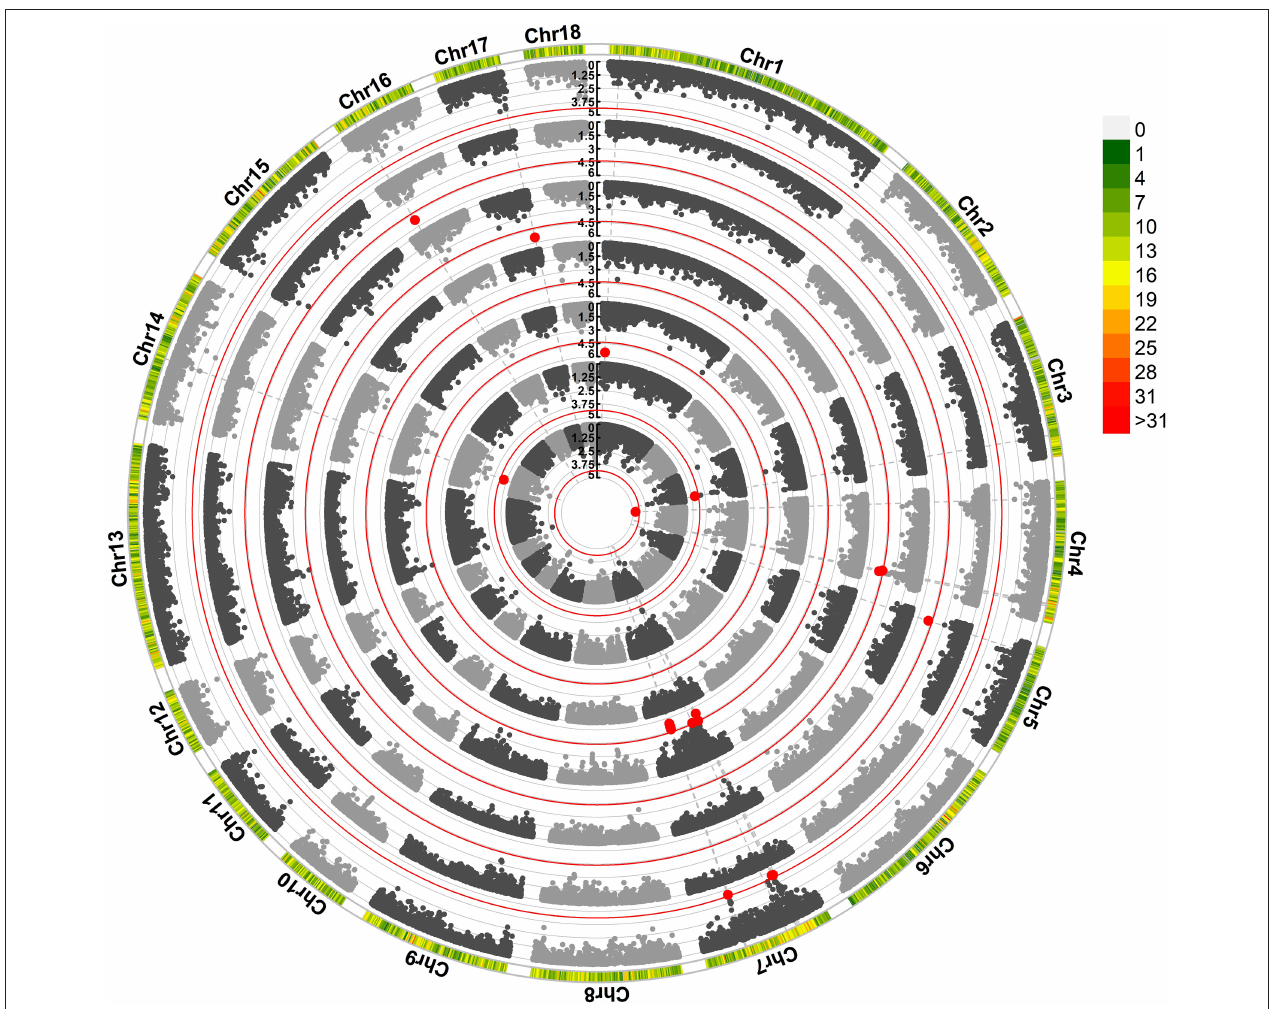
FIGURE 1 | Manhattan plots obtained in the GWAS of litter-size traits. The red line identifies the cut-off for suggestive significance. Red spots identify SNPs with suggestive significance. Traits, from the inner to outer lanes are average birth number (ABN), birth number–second (BN2), birth number–fourth (BN4), birth number–fifth (BN5), birth number–ninth (BN9), and maximum number of